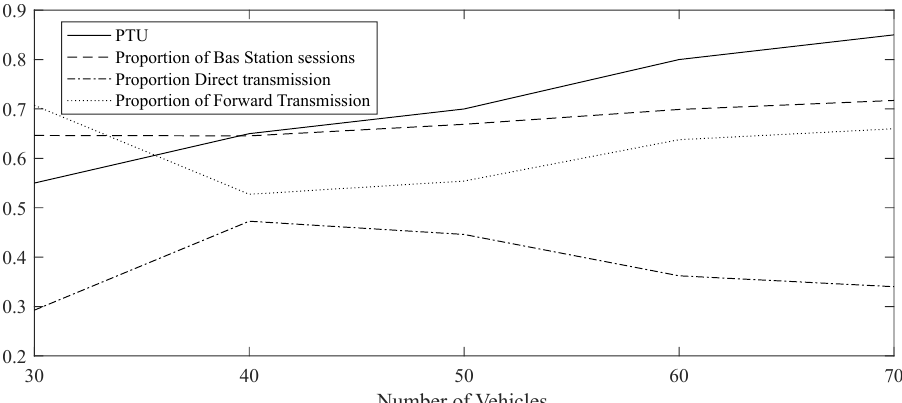
Figure 18. PTU and Some Percentages of Sessions as the number of vehicles